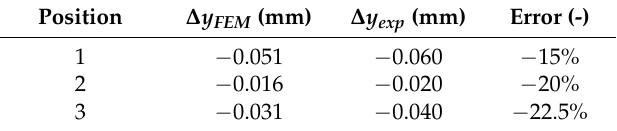
Table 2. FEM displacements and percentage errors with respect to the experimental data.